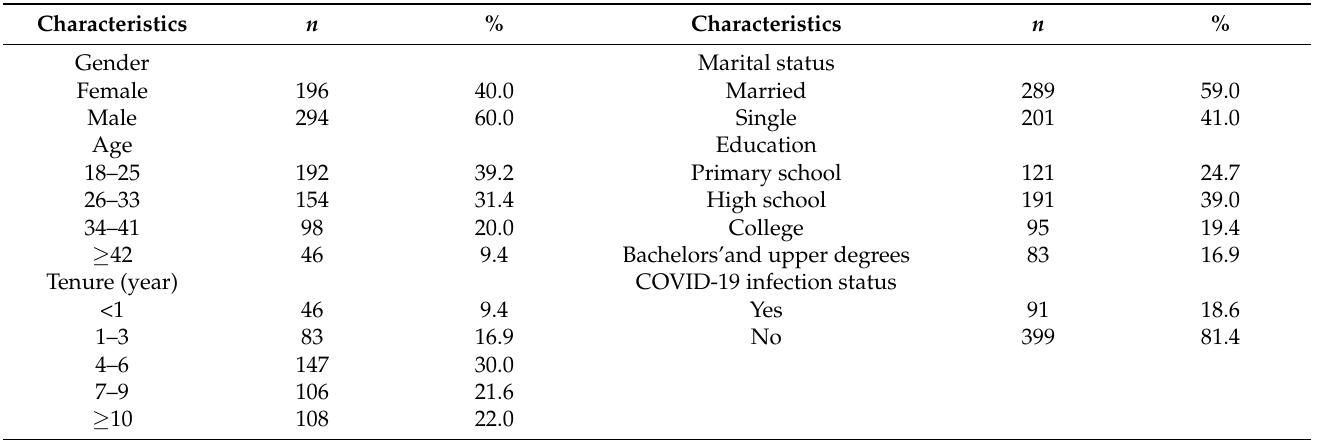
Table 1. Sociodemographic details of respondents ( n =